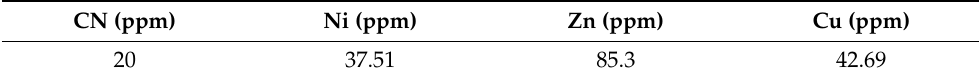
Table 3. Analysis of the effluent taken from the gold processing